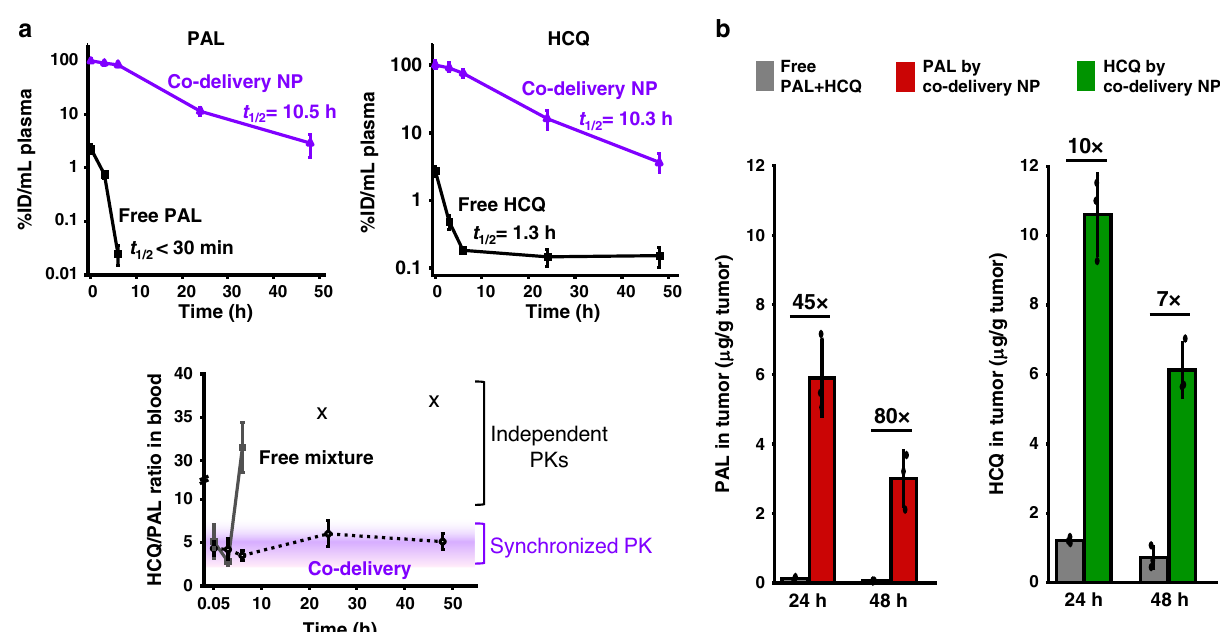
Fig. 3 Co-delivery NP signi fi cantly enhanced the synchronized PK and intratumoral distribution of PAL/HCQ pair after i.v. administration in subcutaneous PANC-1 xenograft mice model. Mice received single i.v. injection of co-delivery NP (with the particle dose of 210 mg/kg) or free PAL/HCQ pair, with an equivalent PAL dose of 10 mg/kg and an HCQ dose of 33 mg/kg that correlated to a PAL/HCQ molar ratio of 1:4.3. a Evaluation of PK pro fi le and PAL/HCQ ratio in plasma. Plasma was collected 0.083, 3, 6, 24, and 48 h post i.v. injection ( n = 3 animals included in each data point). The plasma content of PAL and HCQ was determined by UPLC-MS and expressed as percentage of total injected dose (% ID) per mL of plasma. The circulatory half- life ( t 1/2 ) were calculated by the PKSolver software. The PAL/HCQ ratio in plasma were calculated and plotted versus time. b PAL/HCQ content at the tumor site. In a separate experiment, mice were sacri fi ced at 24 or 48 h post i.v. injection ( n = 3 animals included in each data point). PAL/HCQ content in tumor site was determined by UPLC-MS, and comparison was made between co-delivery NP and direct administration of free PAL/HCQ mixture. Data were obtained from one set of independent experiment without repetition. Data represent mean ± SD; statistical difference was evaluated by